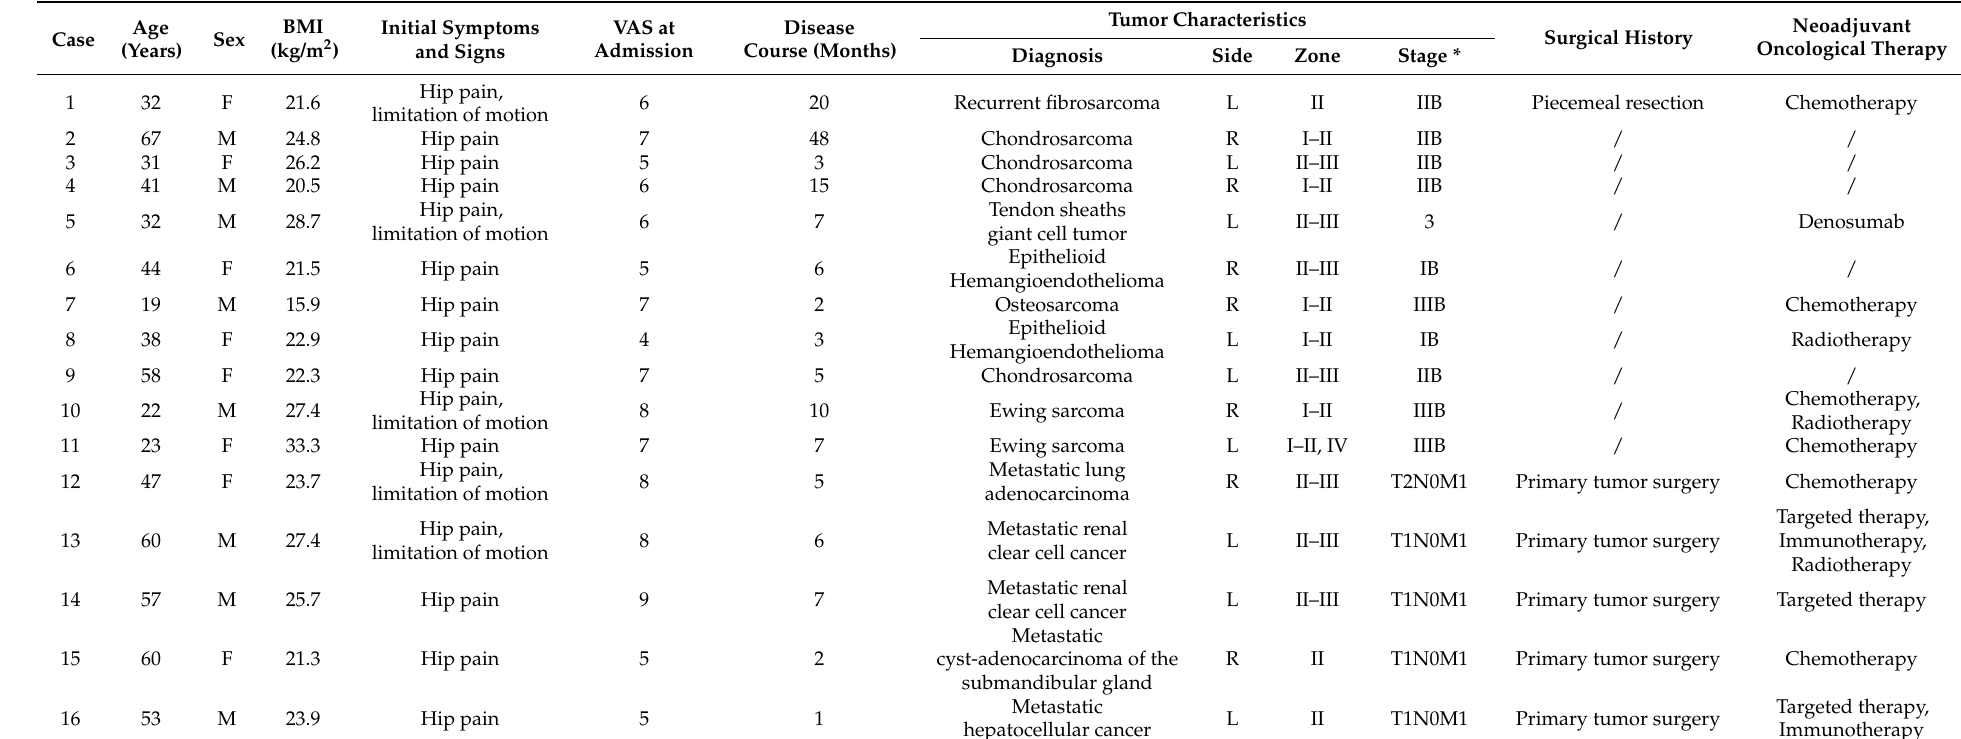
Table 1. Demographic and clinical characteristics of the enrolled